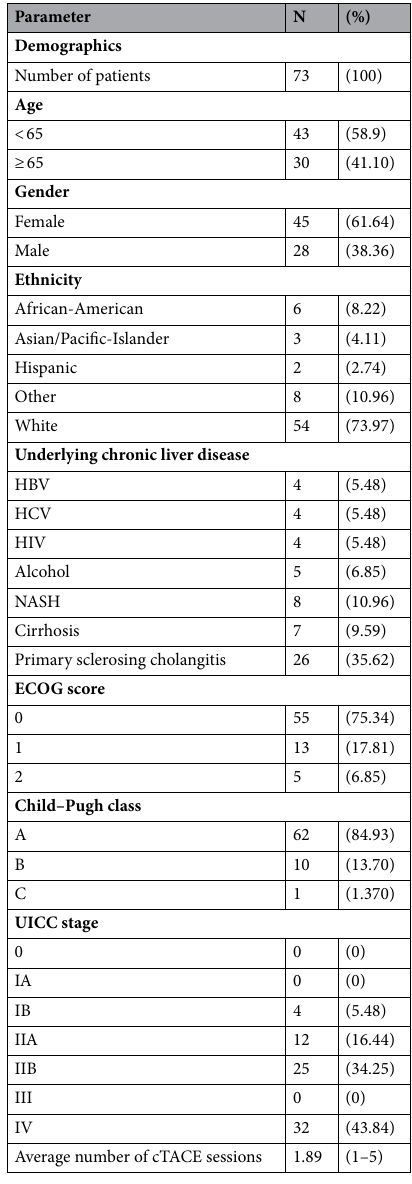
Table 1. Patients’ demographic characteristics. HBV: hepatitis B virus, HCV: hepatitis C virus, HIV: human immunodeficiency virus, NASH: nonalcoholic steatohepatitis, ECOG: Eastern Cooperative Oncology Group, UICC: Union for International Cancer Control, cTACE: conventional transarterial